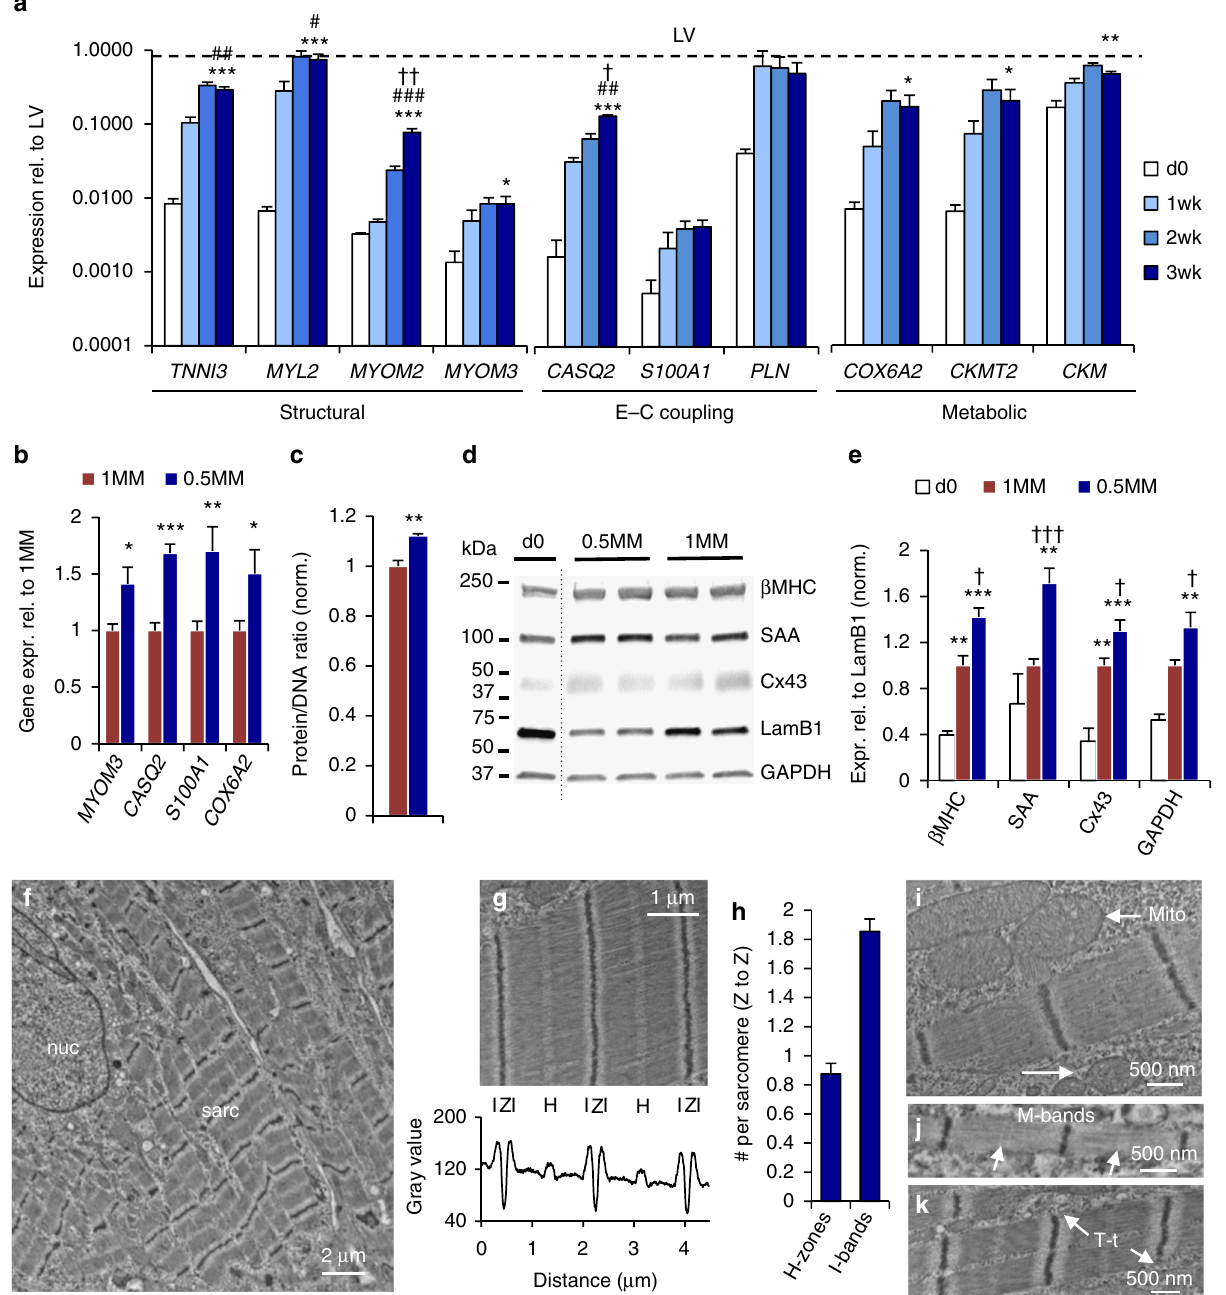
Fig. 4 Increased cell maturation and size in low-density cardiopatches. a Relative expression levels of 10 maturation genes in d0, 1 week, 2 week, and 3 week cardiopatches compared with those in adult human left ventricles (LV). Linear regression from d0 to 3 weeks: TNNI3 , MYL2 , MYOM2 , CASQ2, p < 0.0001; MYOM3 , CKMT2 , p < 0.014; S100A1 , COX6A2 , CKM , p < 0.006; PLN , p = 0.1081. * p < 0.05, ** p < 0.001, *** p < 0.0001 vs. d0; # p < 0.023, ## p < 0.0006, ### p < 0.0001 vs. 1 week; † p < 0.037, †† p < 0.0037 vs. 2 week, via post hoc Tukey ’ s tests. For clarity, only 3-week statistical comparisons are shown. b Relative gene expression in 0.5MM vs. 1MM cardiopatches; * p < 0.041, ** p < 0.0073, *** p < 0.0001, post hoc Tukey ’ s tests. c Protein/DNA ratio in 0.5MM vs. 1MM cardiopatches; n = 3/4 patches (1/0.5MM). d Representative western blots for myosin heavy chain- β ( β MHC), SAA, lamin B1